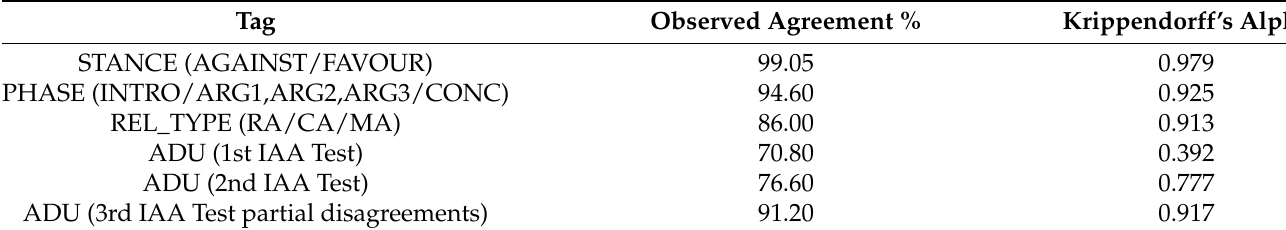
Table 1. Results of the Inter-Annotator Agreement